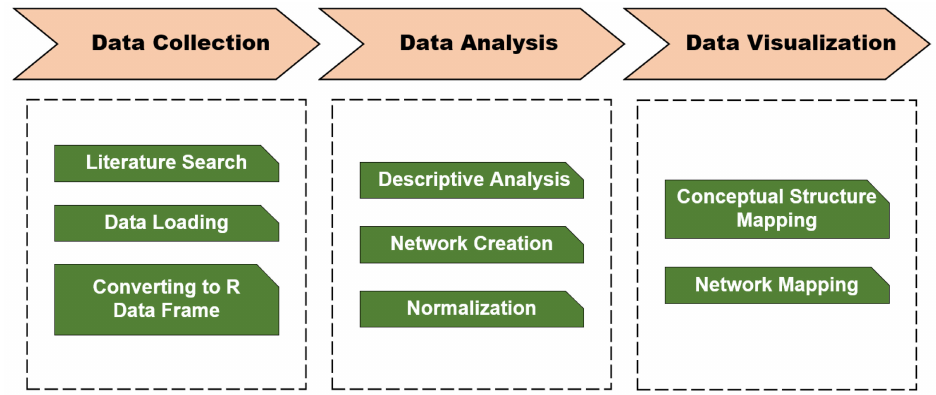
Figure 1. Bibliometrix